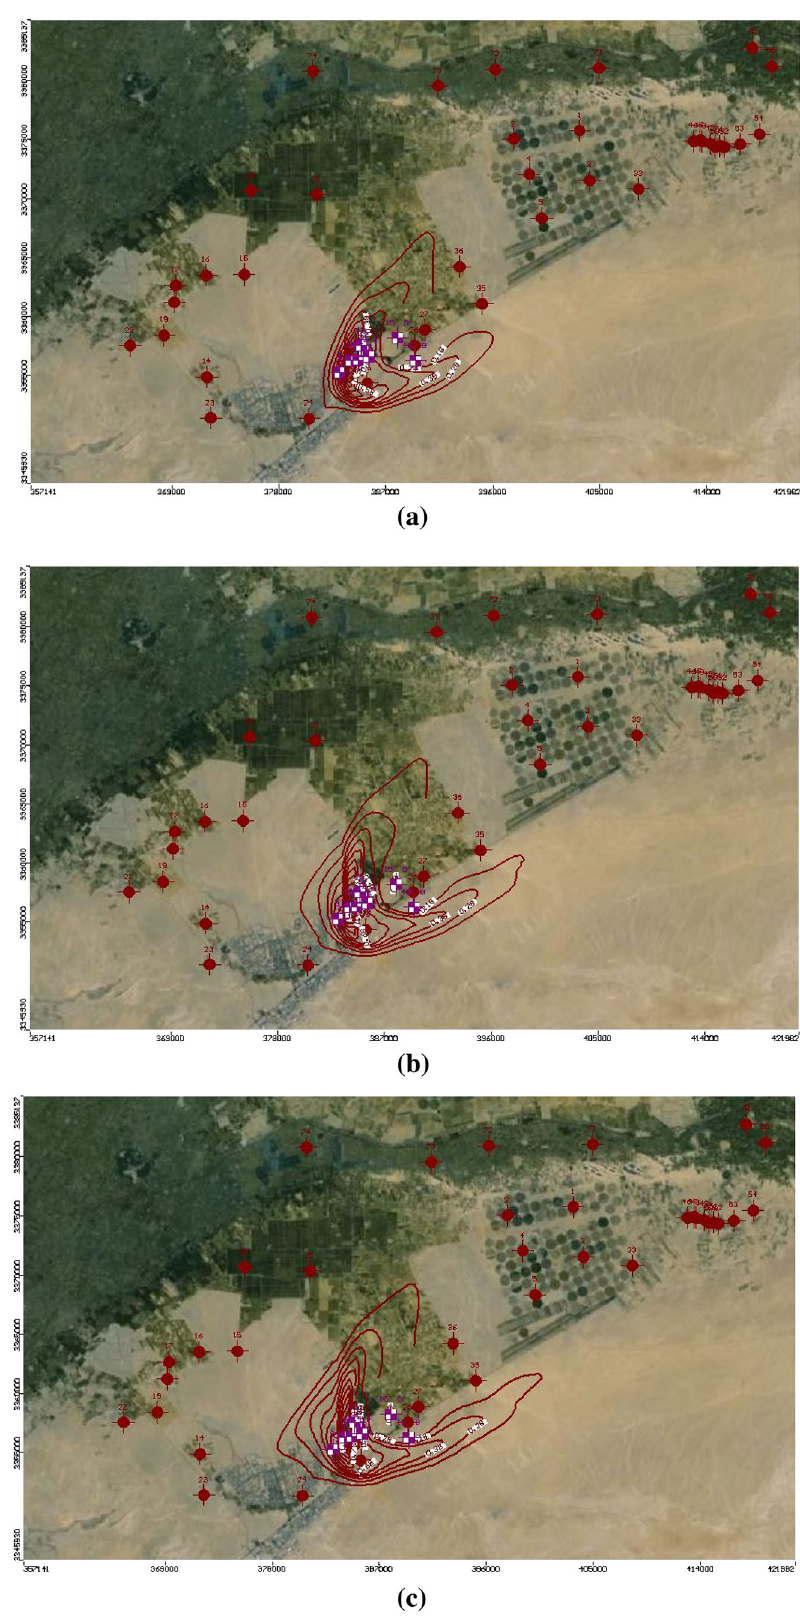
Fig. 11 Al pollutant transport a after 10 years, b after 20 years, and c after 30